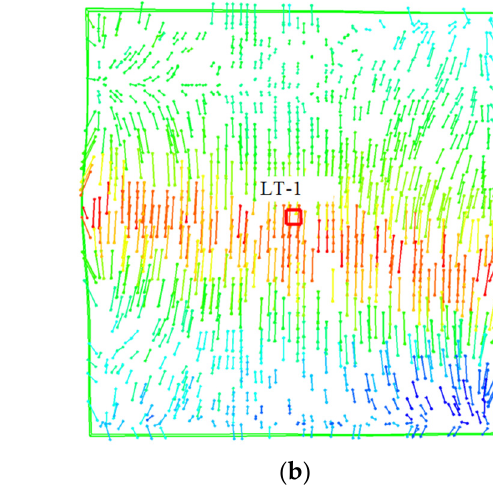
Figure 8. Distribution of the Smax and SHmax of target formation J3q in block LS-1. ( a ) 3D view of the stress Smax distribution. ( b ) plane view of the stress SHmax distribution.